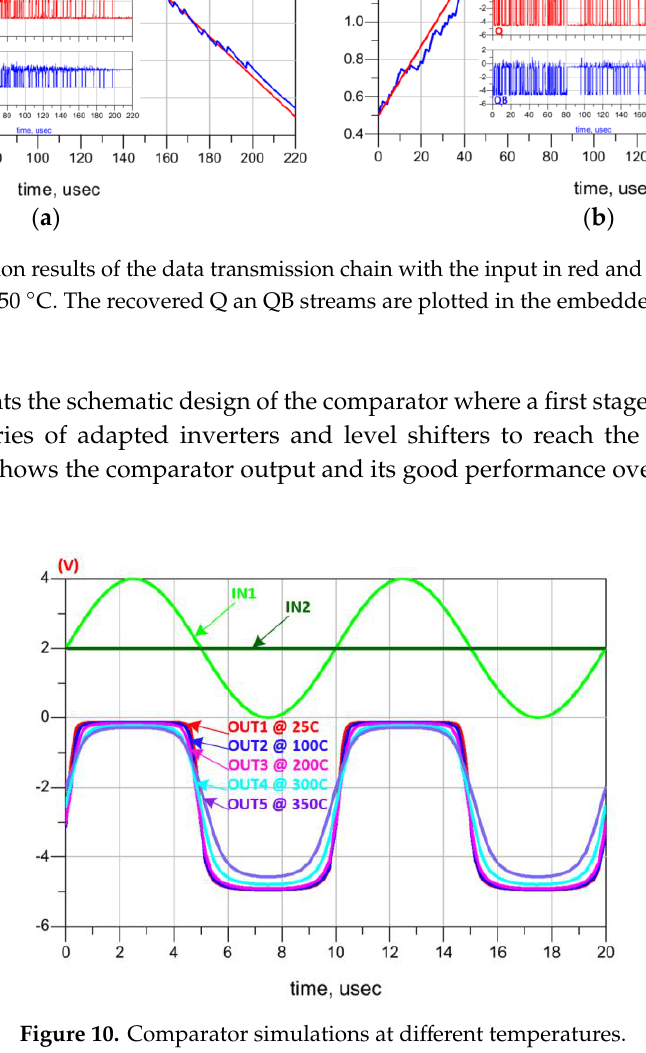
Figure 11. D-Flip Flop simulation results: ( a ) Input signals; ( b ) Output Data.